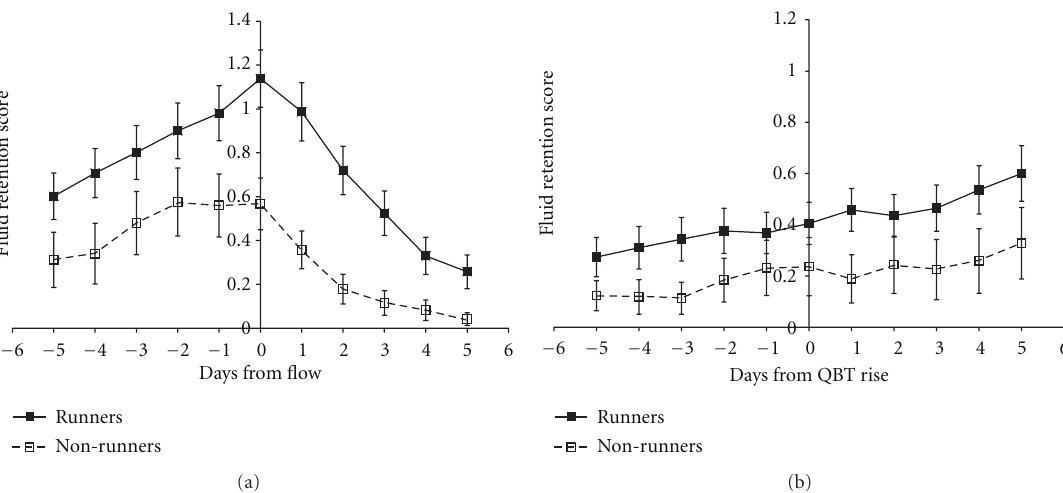
Figure 2: Patterns of fluid retention during the menstrual cycle for runners ( n = 39) and normally active women ( n = 23) relative to (a) the onset of menstrual flow, where 0 is the first day of flow, and (b) in ovulatory cycles only; the first day of elevated basal temperature is shown (denoted QBT rise) estimated by the validated quantitative basal temperature algorithm (QBT). To correct for di ff erences in the duration of data collection by women, data are the average (bars ± standard error of the mean) of within-woman averages. Data were collected by 62 initially ovulatory women over one year. Fluid retention/“bloating” was scored from 0–4 using the Daily Menstrual Cycle diary.